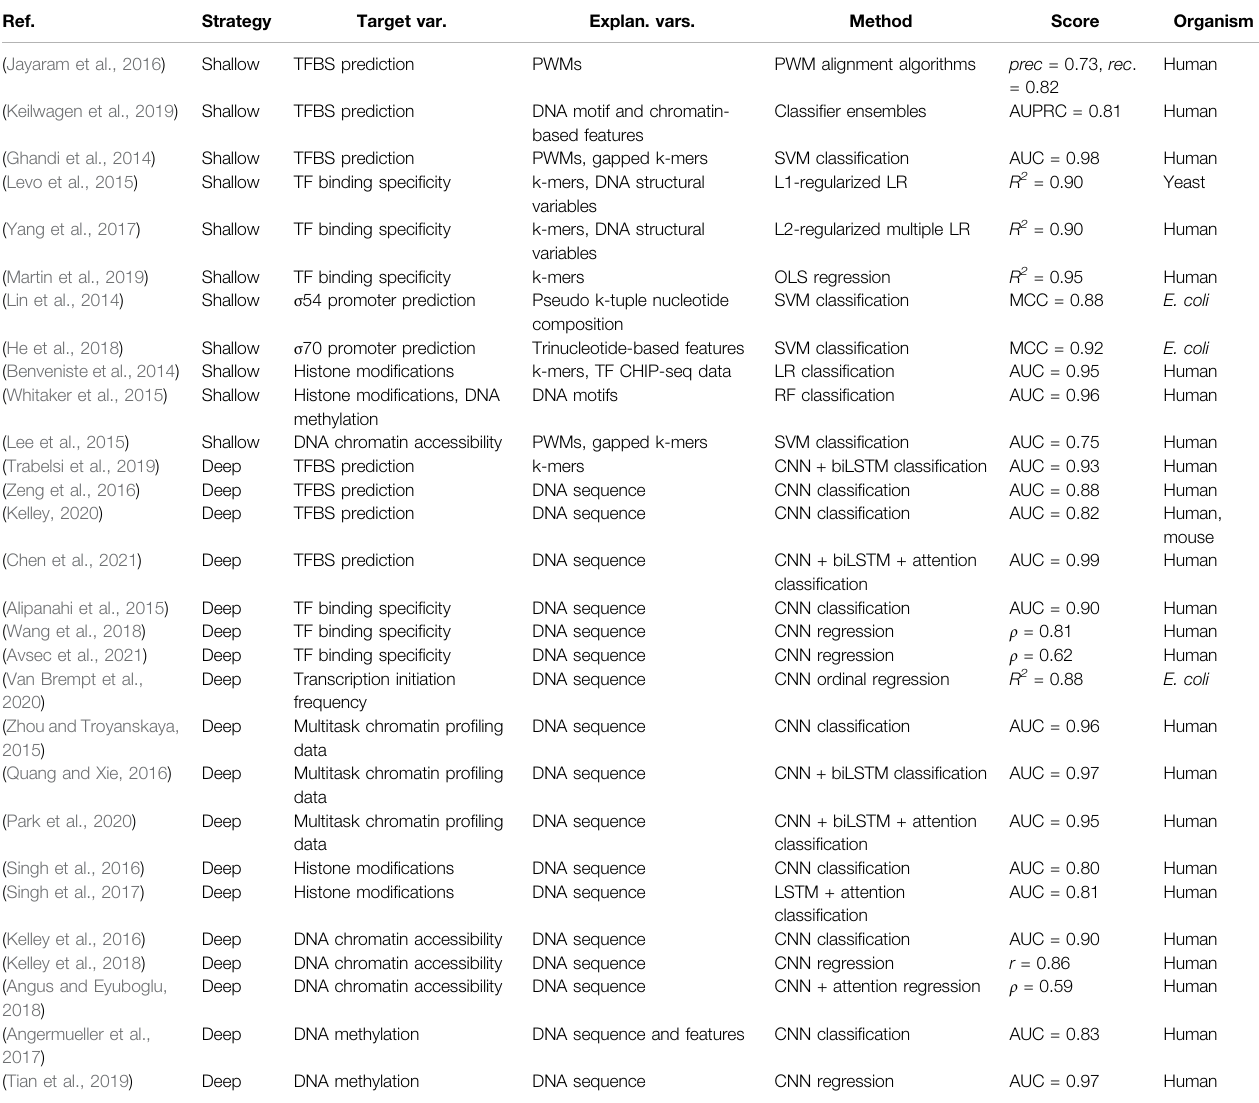
TABLE 1 | Overview of studies modeling protein-DNA interactions that govern the initiation of gene expression from nucleotide sequence properties. Highest achieved or averagescoresarereported,ontestsetswhereapplicable,andincludeprecision( prec )andrecall( rec ),areaunderthereceiveroperatingcharacteristiccurve(AUC),area undertheprecisionrecallcurve(AUPRC),thecoef fi cient ofvariation ( R 2 ),Pearson ’ scorrelation coef fi cient( r ),Spearman ’ scorrelationcoef fi cient ( ρ )and Matthews correlation coef fi cient (MCC).